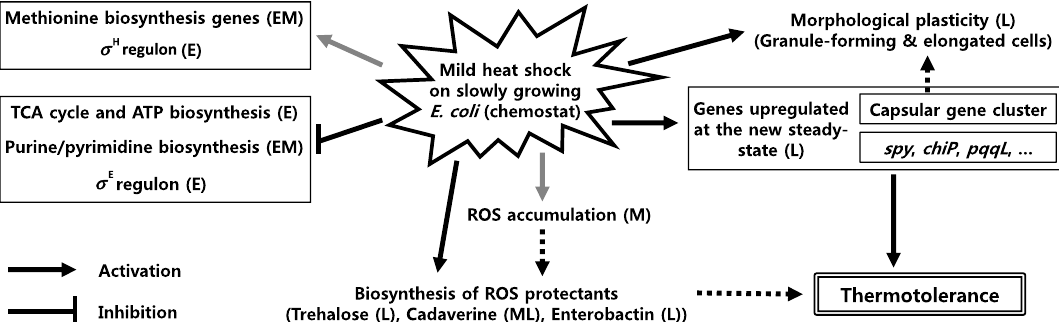
Figure 6. A proposed regulation model of E. coli in response to the prolonged heat stress. The solid black lines represent the findings of this study. The solid gray lines denote the present results that agree with those of previous studies. The dotted lines represent the hypothetical links suggested in this study, requiring experimental validation. Arrows represent the activation influences, and blunt-headed lines denote repression. Rectangles depict the biological processes or their associated genes, and the parentheses denote the early (2 and 10 min; E), middle (0.5, 1, and 2 h; M), and late (4, 8, and 40 h; L) stages of heat